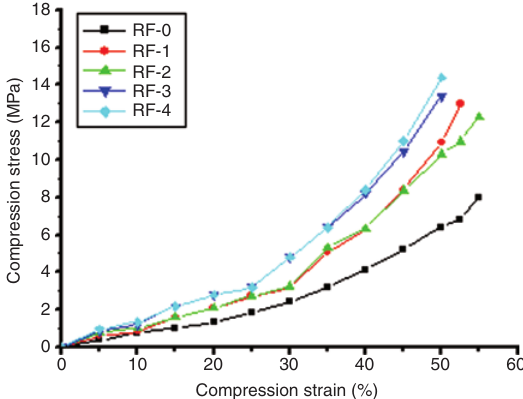
Figure 7 Compression stress and strain curves for tire cord-reinforced CR rubber.